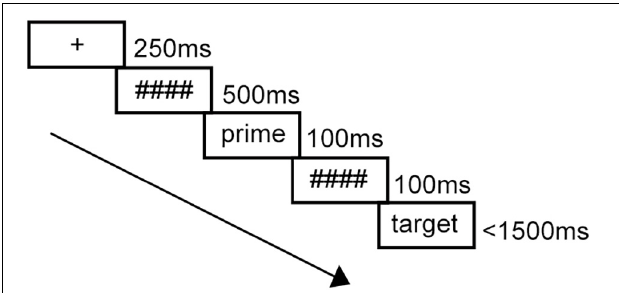
FIGURE 1 | Trial structure of the